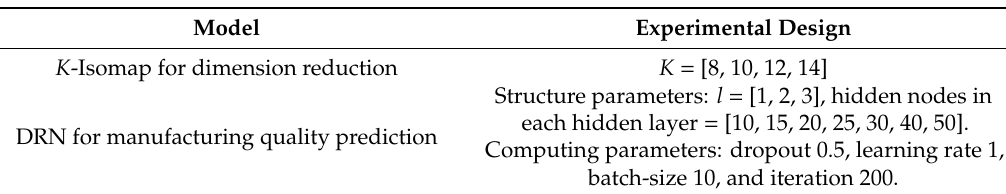
Table 2. Experimental designing of each approach. Model Experimental